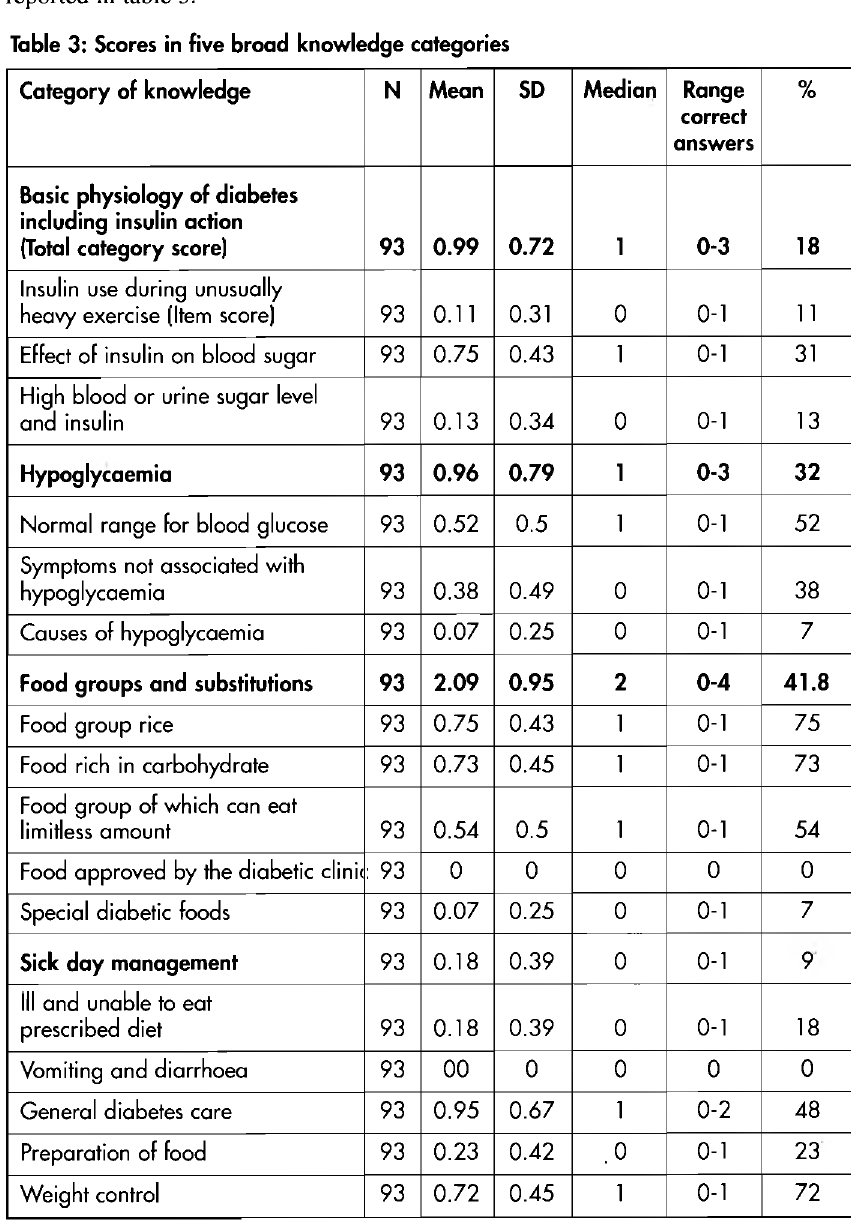
Table 3: Scores in five broad knowledge